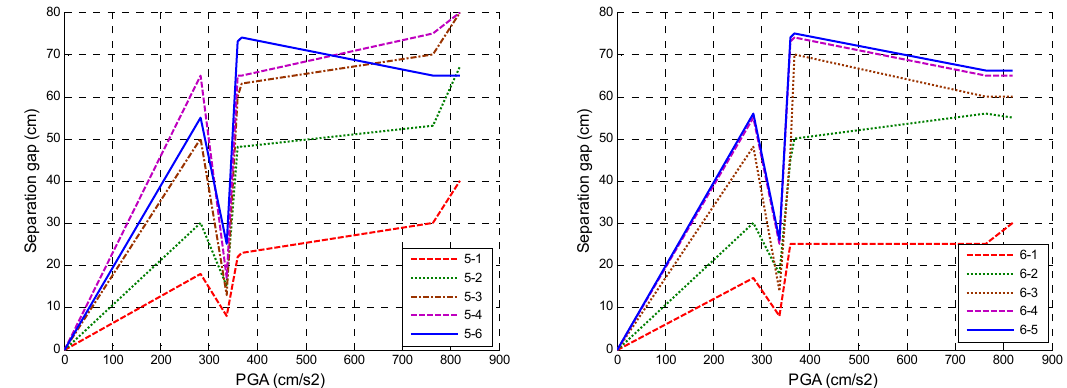
Figure 4. Required seismic gap with relation to the peak ground acceleration (PGA) of earthquake records for different structural arrangements.